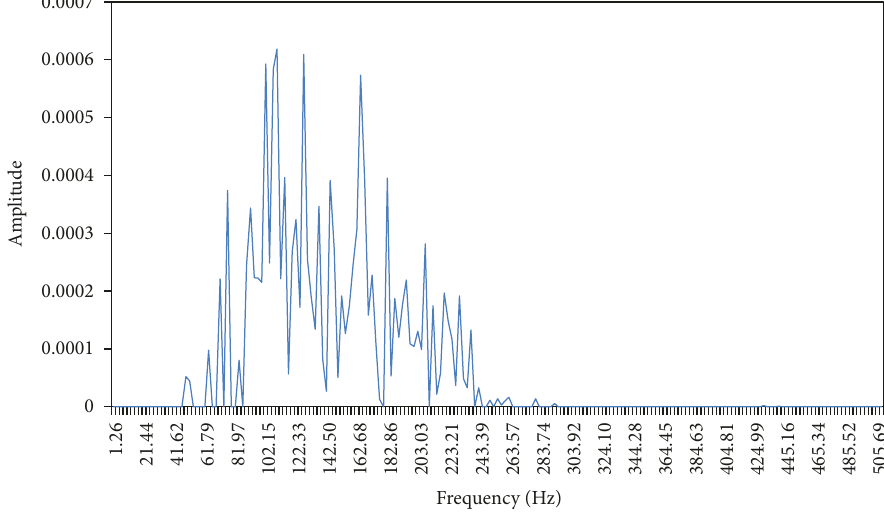
Figure 14: Marginal spectra of IMF-3 signalled with relative